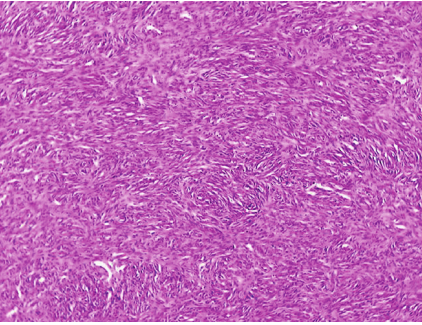
Figure 2: Buccal mucosa BFH: Intraoperative view of the lesion.